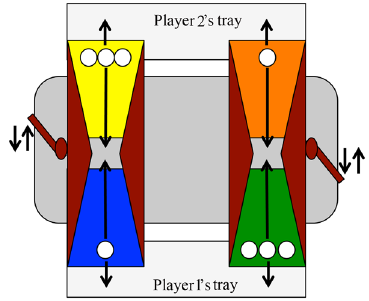
Figure 1. The Prisoner’s Dilemma Game apparatus consisted of two similar but independent trays (one for each player) operating in a seesaw-like fashion that delivered rewards to the players. Each player had control over one of the two trays. For instance, Player 1 would decide whether to choose the blue side (i.e., defect, as it delivers one reward to Player 1) or the yellow side (i.e., cooperate, as it delivers three rewards to Player 2) while Player 2 would decide whether to choose the orange side (i.e., defect) or the green side (i.e., cooperate).